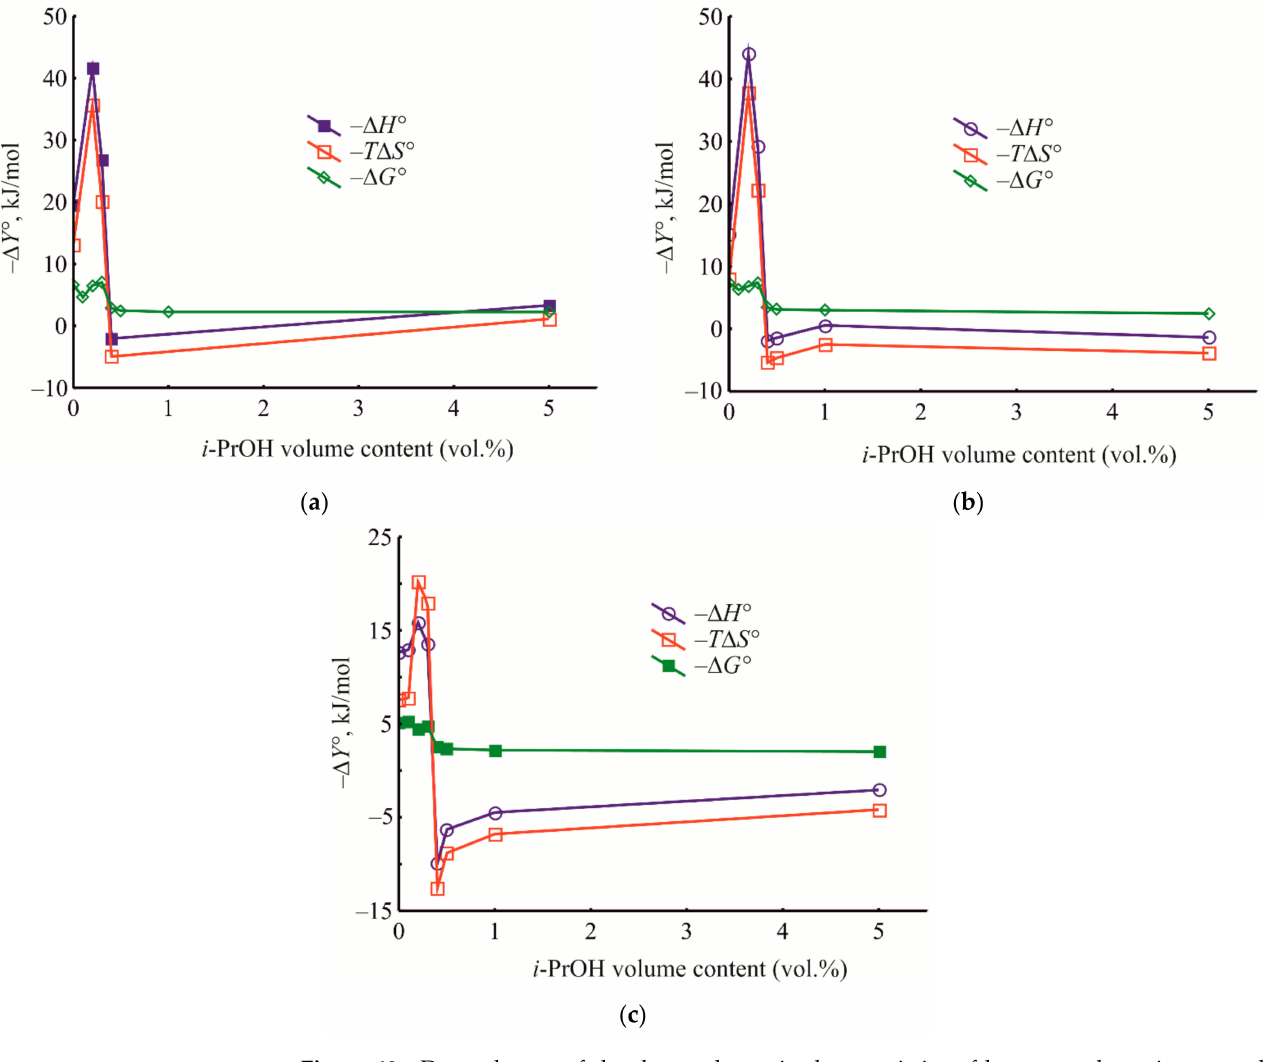
Figure 12. Dependences of the thermodynamic characteristics of benzene adsorption onto the HKUST-1@BPS composites 1 , 2 , 3 ( a – c ) on the i -PrOH content (vol.%) in the mobile